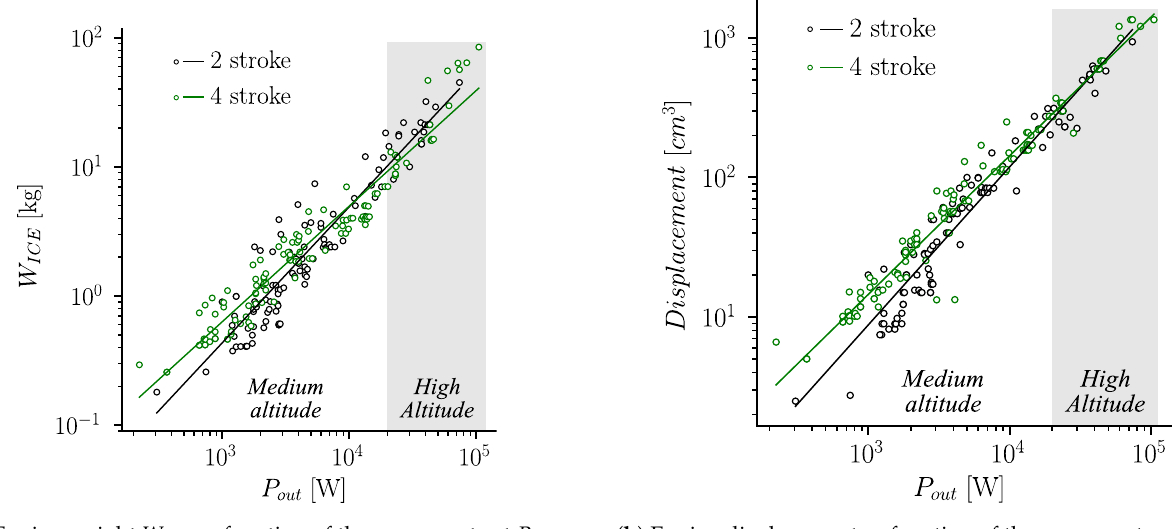
Figure 9. Sizing correlations for ICE engines from 200 to 100,000 W of cruise power. Table 4. Weight of ICE engines, regression coefficients. W